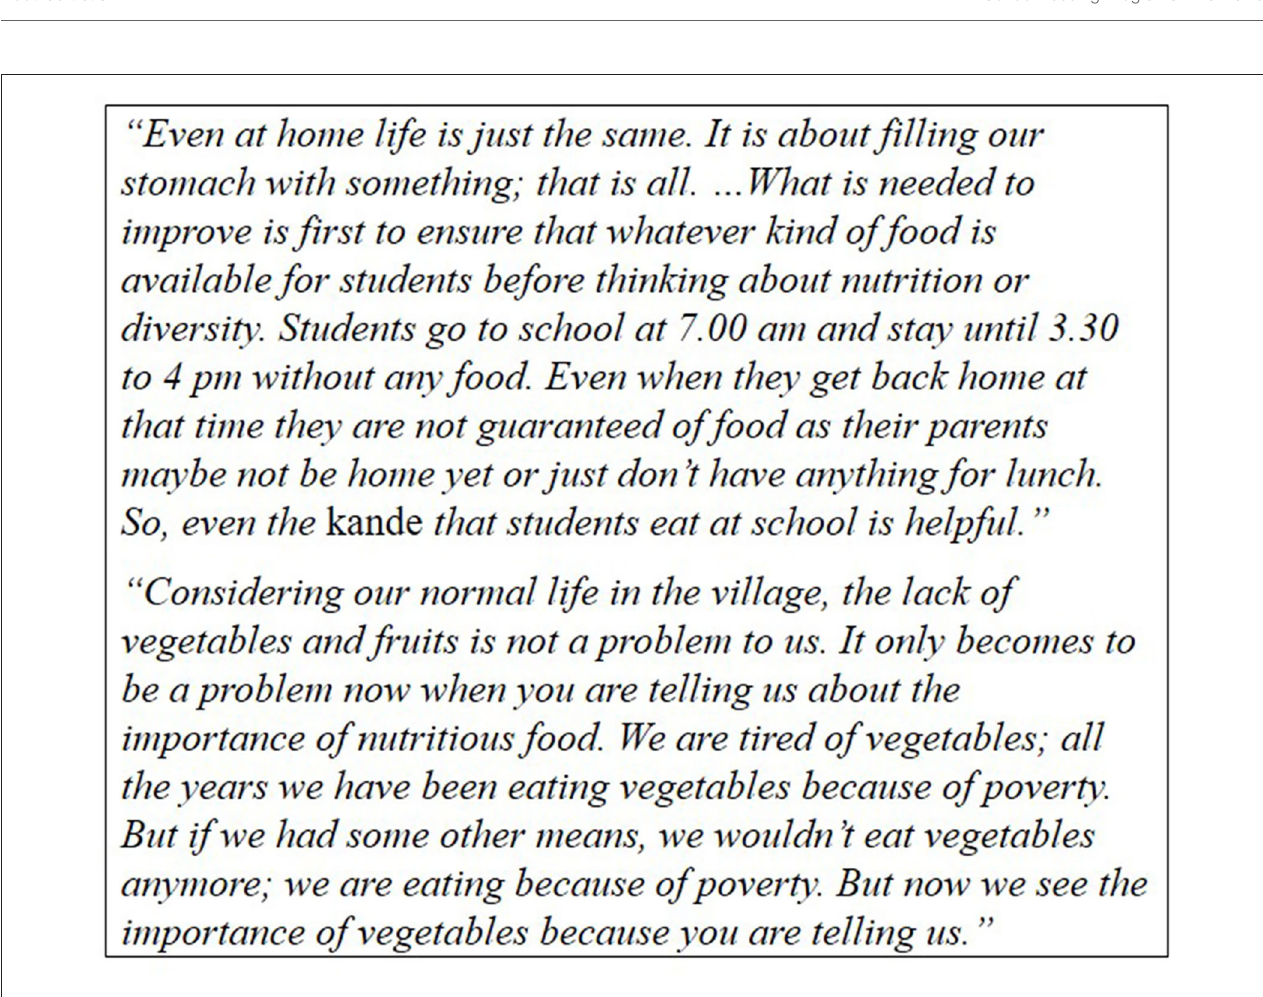
FIGURE 2 | Perceptions of parents toward vegetables in